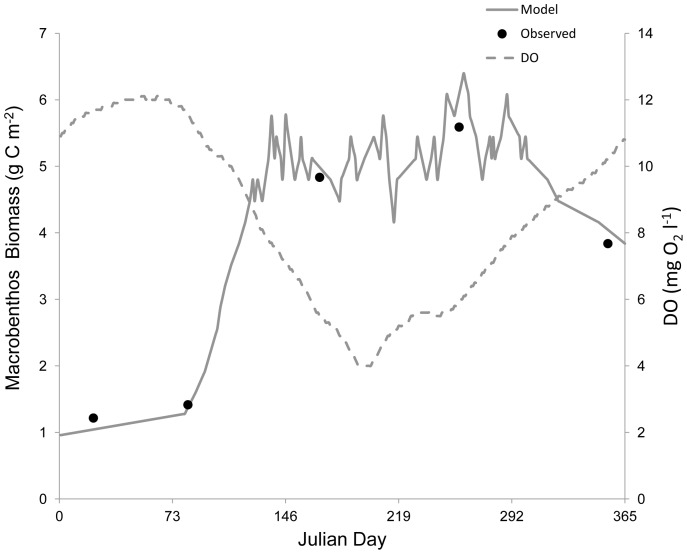
Verification of the macrobenthos state variable during normoxia.Left y-axis: the gray solid line represents modeled macrobenthos biomass and the black dots denote observed macrobenthos biomass from site LE3.4 of the Chesapeake Bay Benthic Monitoring Program in 1992. Right y-axis: the grey dashed line indicates the dissolved oxygen concentration. Modeled macrobenthos biomass matched the trends and magnitude of observed macrobenthos biomass in 1992.